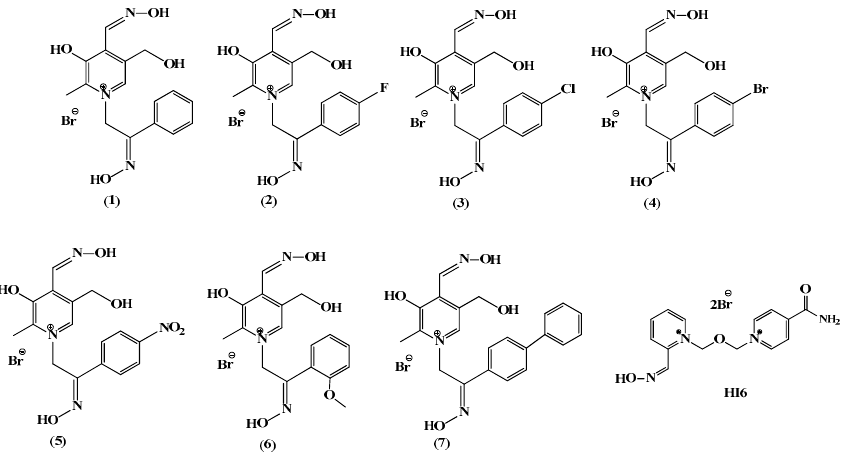
Figure 1. The chemical structures of the tested pyridoxal dioximes 1 – 7 and medically approved oxime